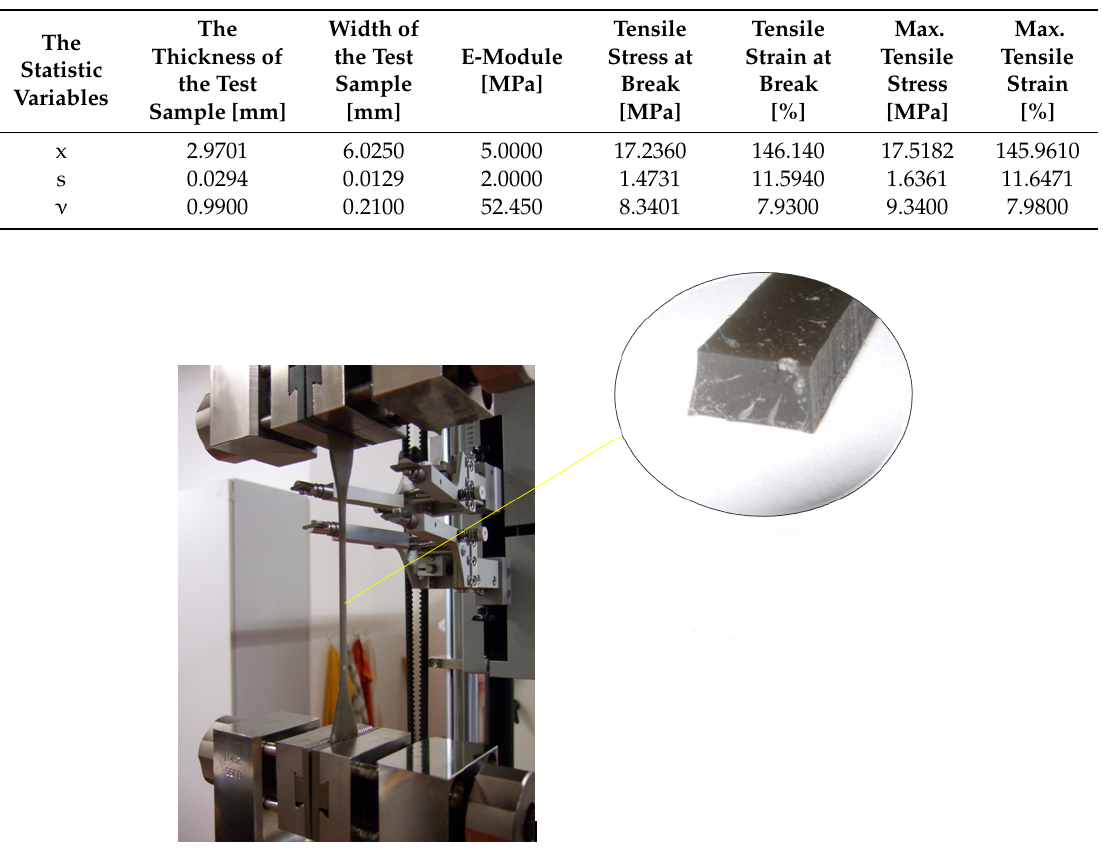
Table 5. Tensile test results according to DIN EN ISO 527 before exposure to laboratory light sources.